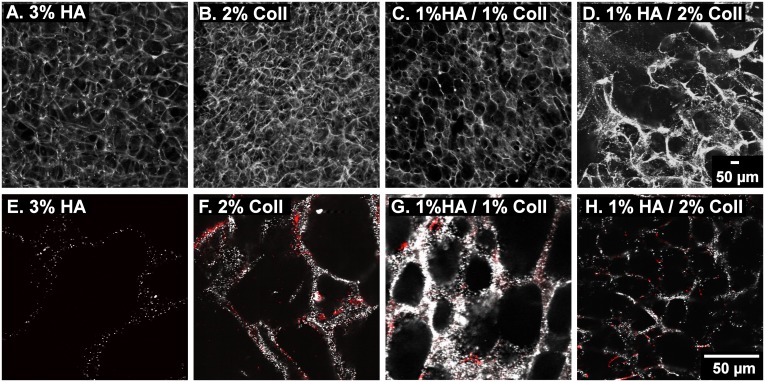
Morphology of swollen cryogels.LSM images of fluorescent tracer particles localized in the gel network. 3D stack (A-D) and corresponding 2D image, 40x magnification, with anti-Coll staining shown in red (E- H).